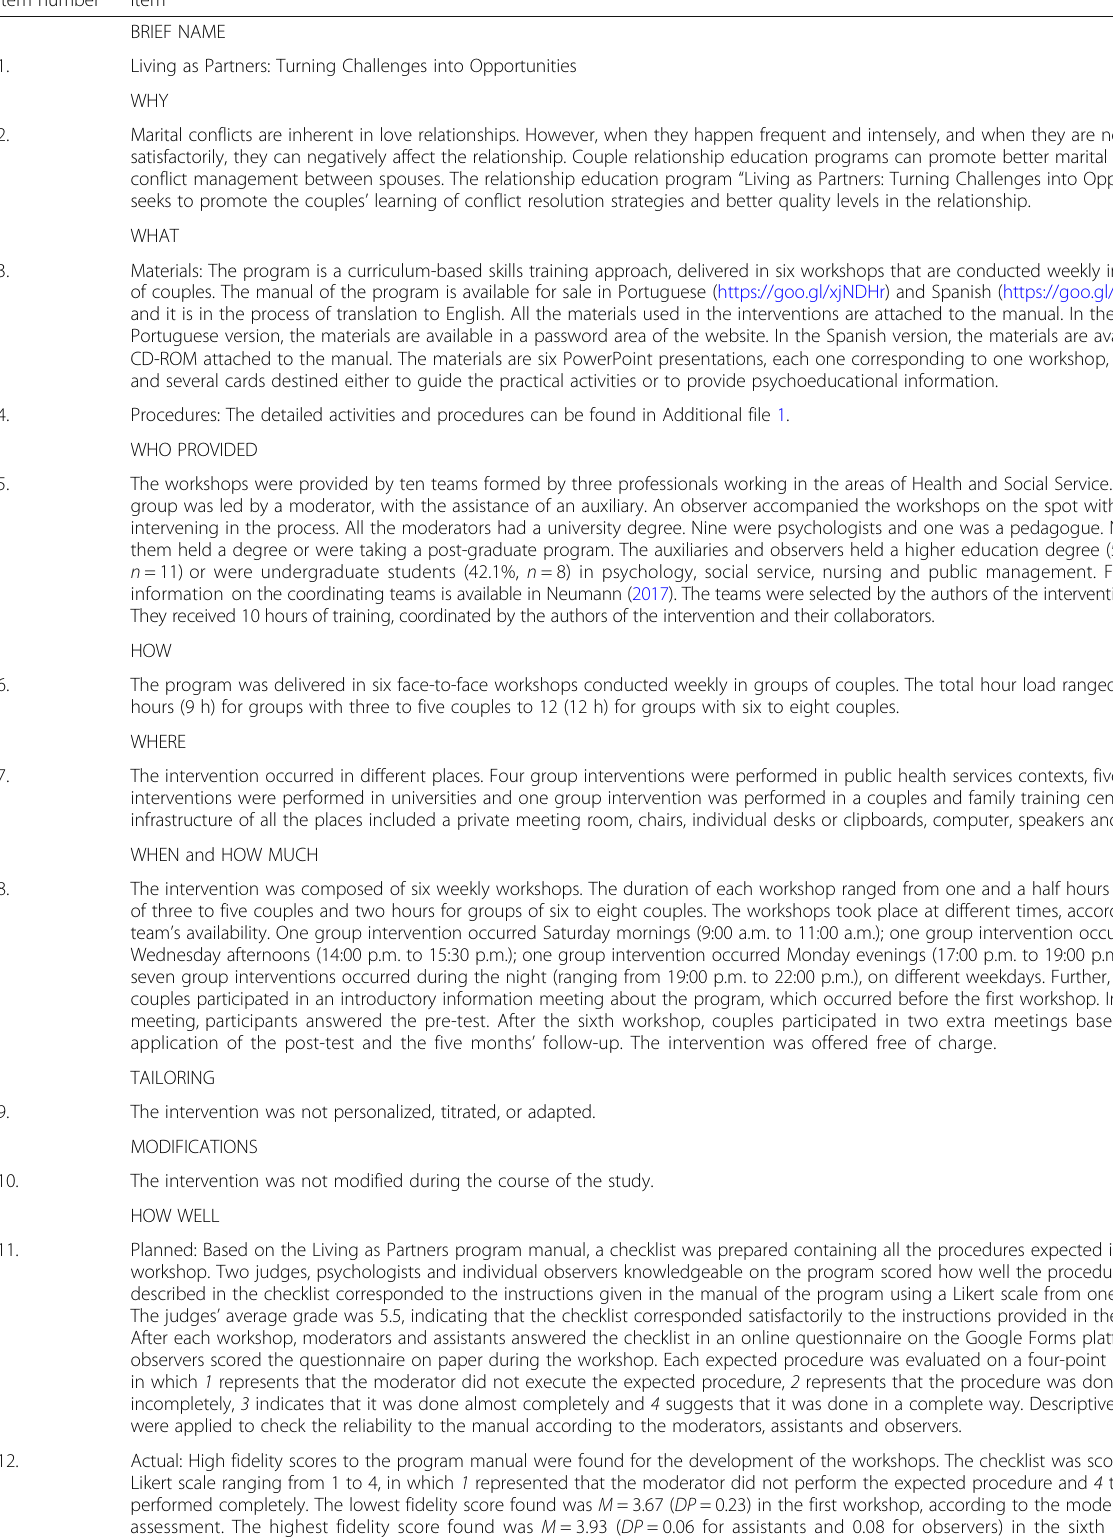
Table 1 Intervention Description and Replication (TIDieR)